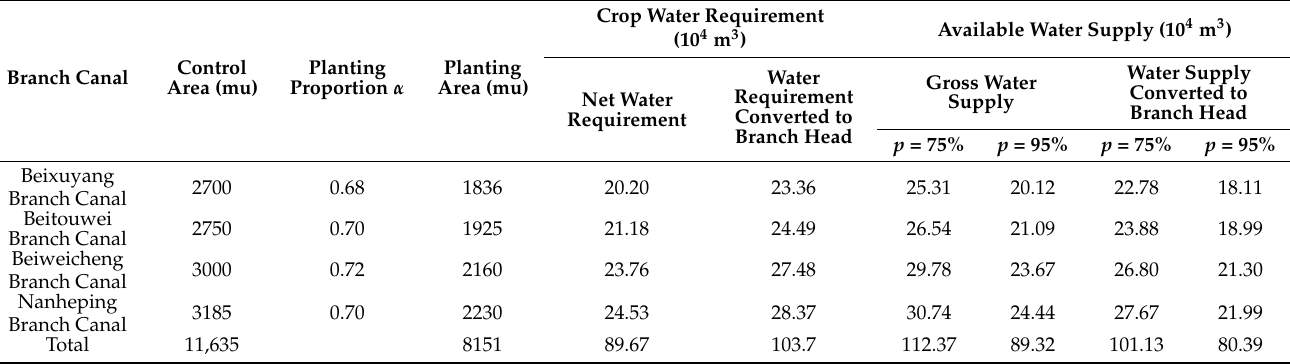
Table 3. Analysis of water supply and demand during the ponding period of rice for each piece of the water receiving area corresponding to each branch canal in the Hengliu Main Canal system in different year